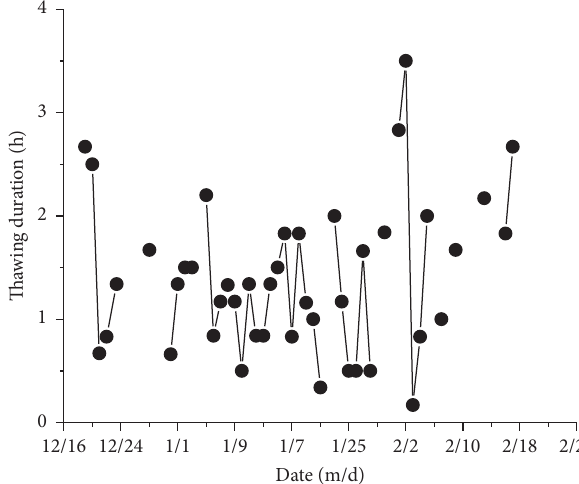
Figure 7: Variation of the daily thawing duration of the compacted gravelly soil without covering the thermal insulation materials on the dam core wall from December 18, 2016, to February 22, 2017 with